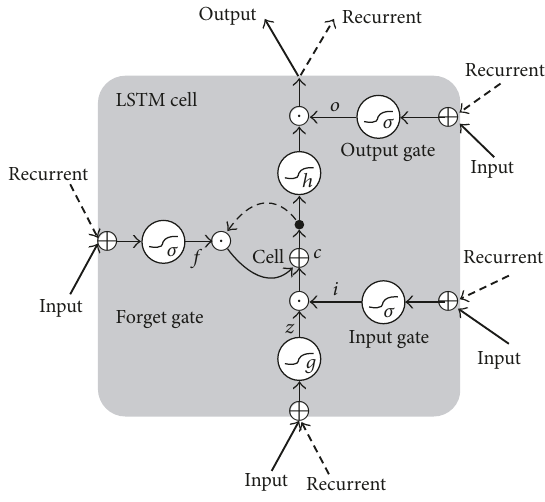
Figure 1: Schematic of LSTM unit